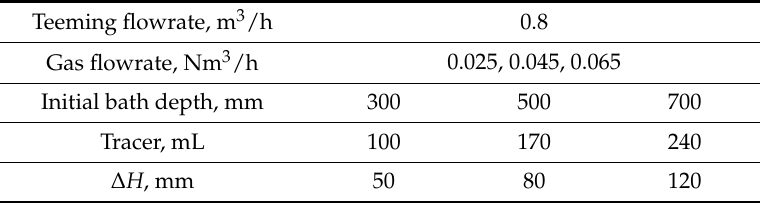
Figure 4. Tracer patterns in different teeming depths. Table 1. Parameters used in the experiments.